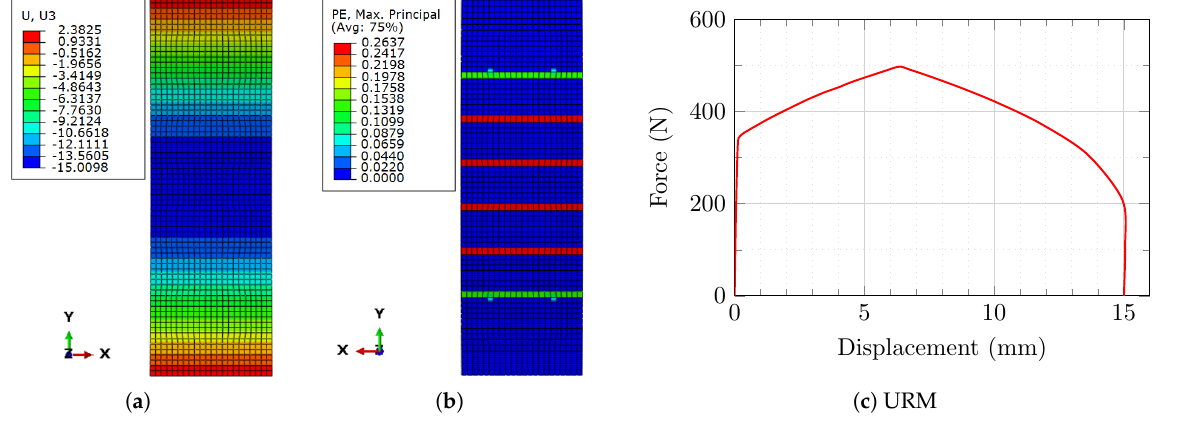
Figure 14. The behavior of the masonry prism: ( a ) residual displacement in the direction of loading (U 3 , U Z or out-of-plane); ( b ) residual plastic strains; ( c ) relationship between reaction forces and maximum